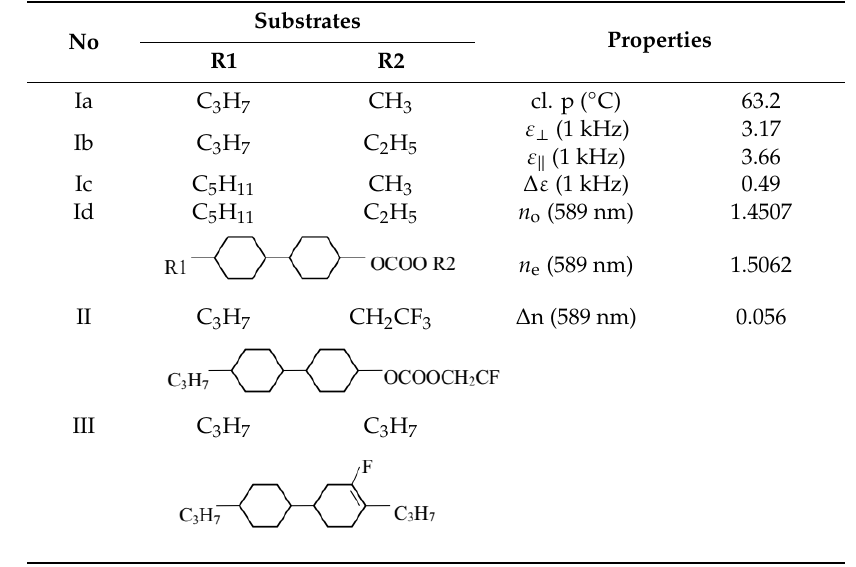
Table 1. Properties of the LC mixture 3092 A